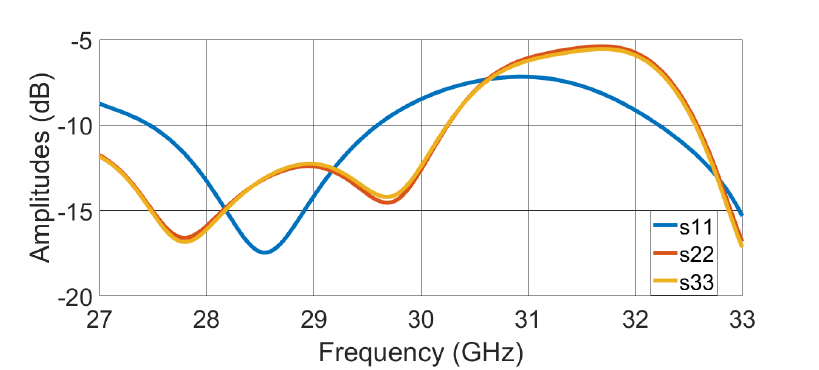
Figure 22. Calculated array factor radiation patterns at 27 GHz and 30 GHz when the outputs of the proposed Rotman lens (Figure 10) are used to excite the phased array.